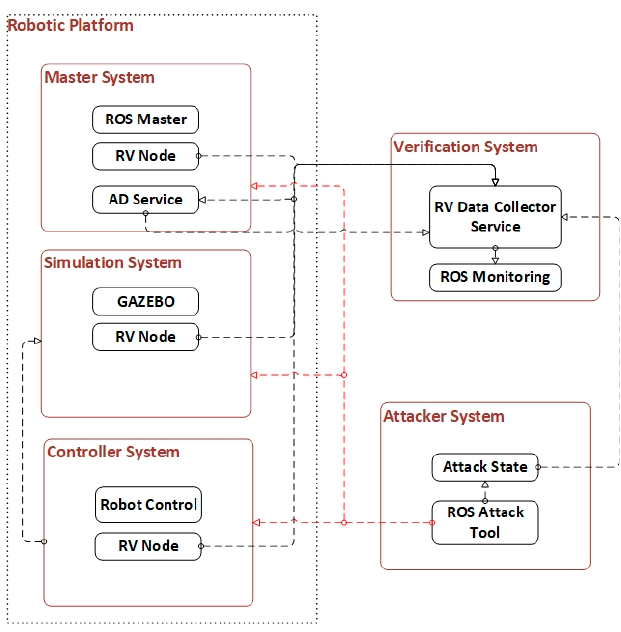
Figure 1. Runtime verification architecture.